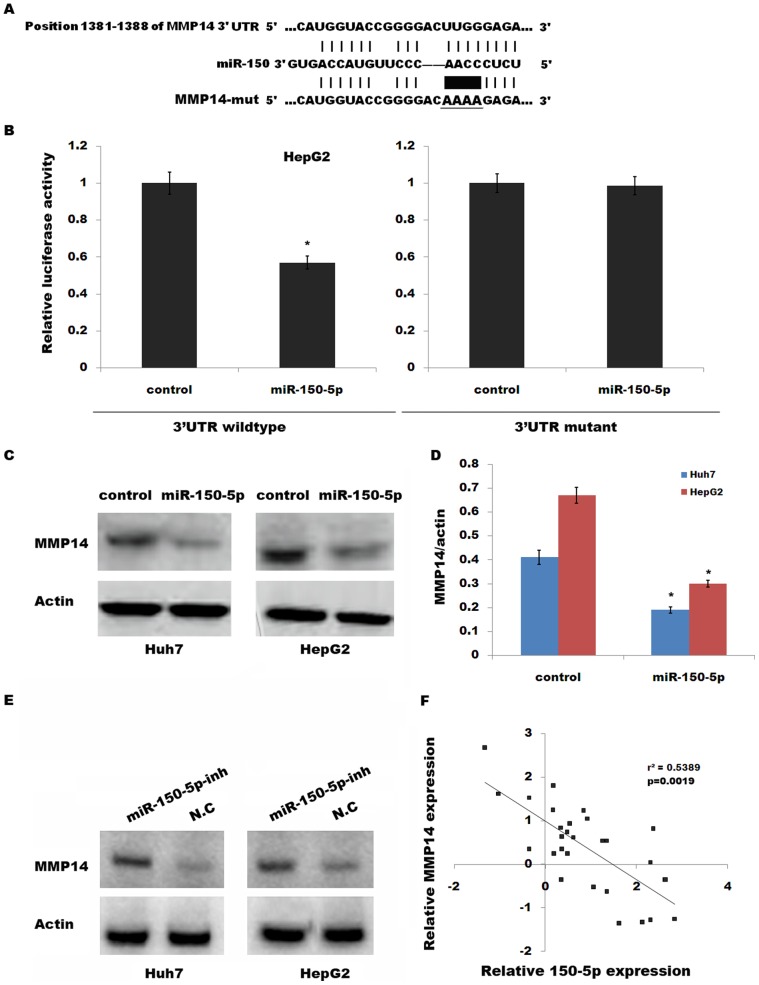
miR-150-5p directly targets MMP14.(A) Schematic representation of the miR-150-5p site in MMP14 3′-UTR. (B) The 3′UTR reporter assay was carried out in HepG2 cells overexpressed with miR-150-5p. pGL3-MMP14-3′-UTR-WT or pGL3-MMP14-3′-UTR-Mutation was co-transfected with pRL-TK. Luciferase assays were performed 48 h after transfection. Firefly luciferase activity was standardized to Renilla luciferase control. *p<0.05. (C and D) Western blot analysis for endogenous MMP14 protein level after miR-150-5p overexpression in hepatoma cells. (E) Western blot analysis for endogenous MMP14 protein level after miR-150-5p inhibition in hepatoma cells. miR-150-5p-inh, miR-150-5p inhibitor. (F) A significant negative correlation between miR-150-5p and MMP14 expression in
vivo (r
2 = 0.15389 p = 0.0019).